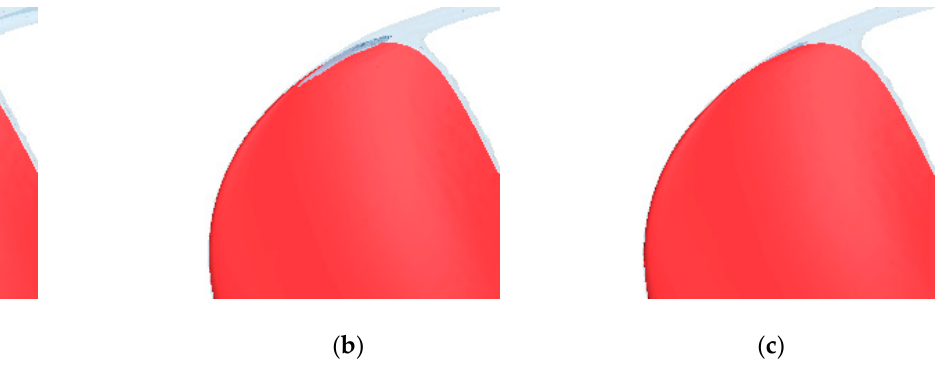
Figure 13. Development of TVC ( a : rigid, b : model 1, c : model 5, σ = 1.2).